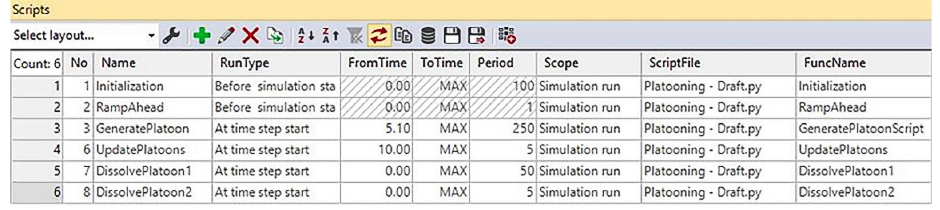
Figure 2. COM interface